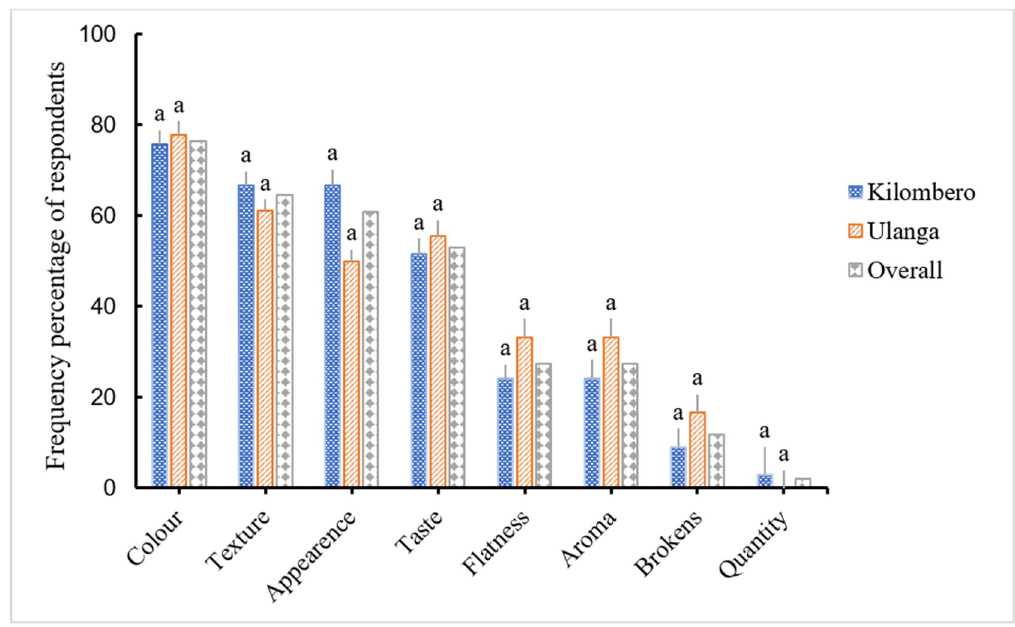
Fig 8. Factors considered by consumers when buying pepeta product in the study area. Kilombero–Kilombero district, Ulanga–Ulanga district. Bar with different letter are significant different at p < 0.05 for each parameter. Source: Survey